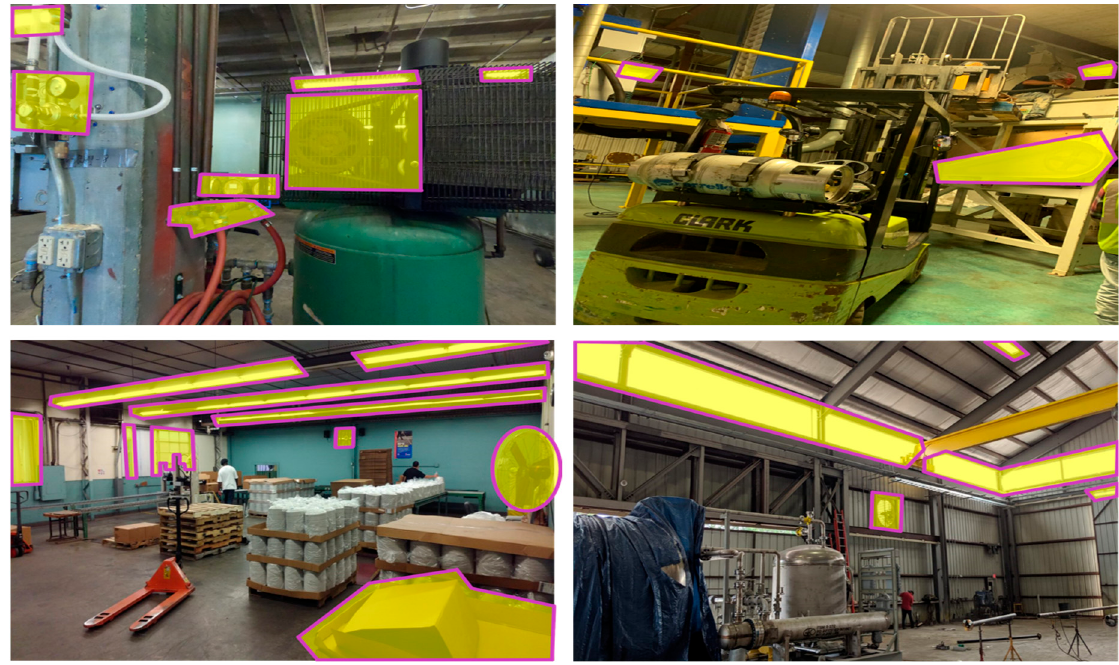
Figure 2. AOIs are highlighted for the